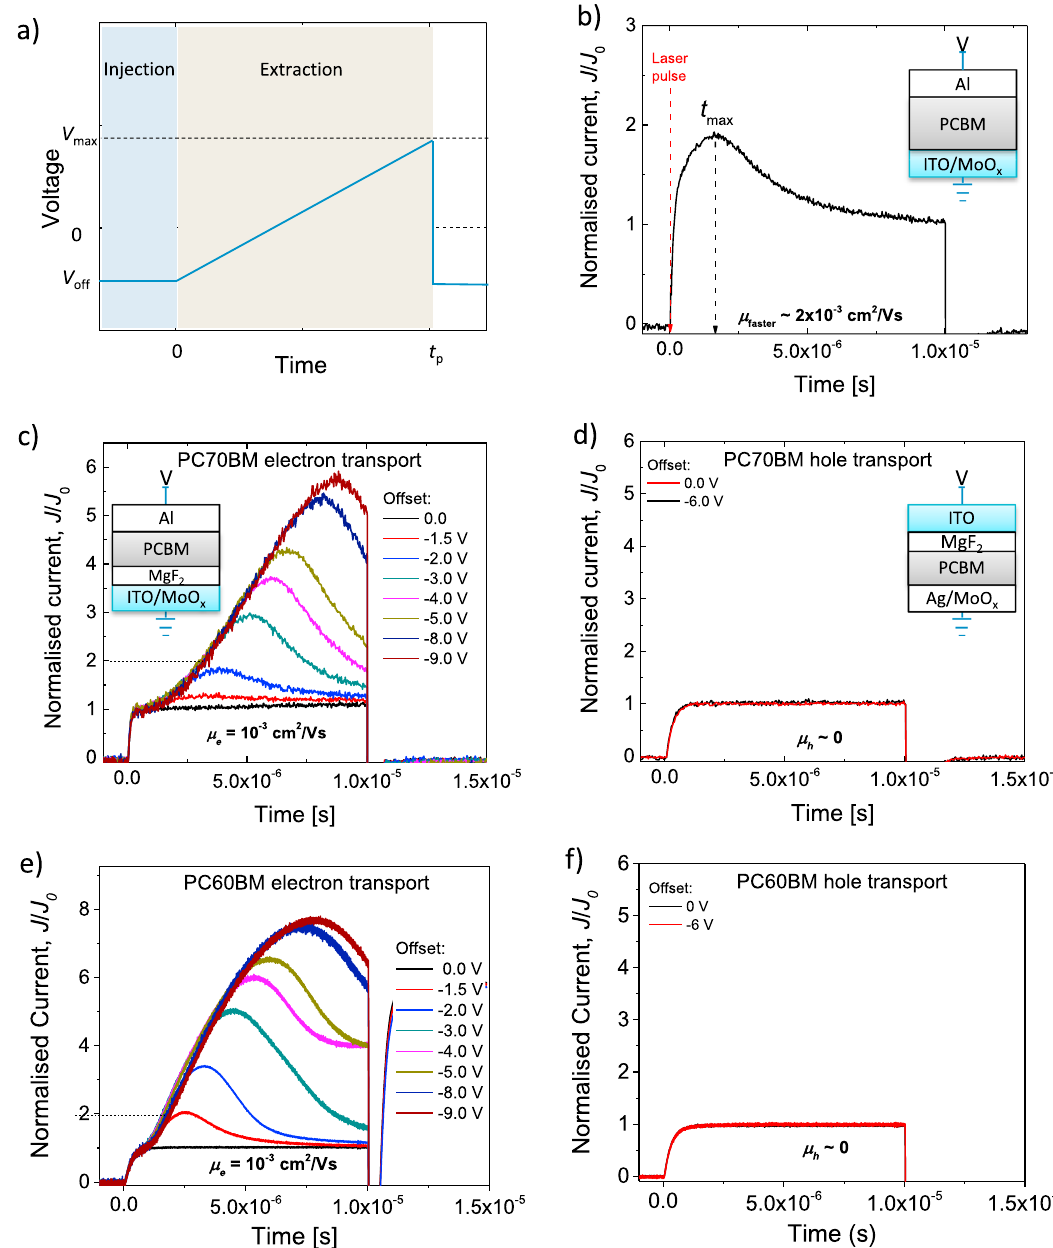
Fig. 1 Photo-CELIV and MIS-CELIV experimental results for PC70BM and PC60BM. a A schematic of the pulse shape used in photo- and MIS- CELIV measurements. At t < 0 a negative offset is applied to the device (forward bias) allowing injection of carriers (only for MIS-CELIV) and t > 0 the triangle voltage pulse extracts the injected carriers. b Photo-CELIV transient for a PC70BM diode structure is shown in the inset. The faster carrier mobility is measured, as photo-CELIV is insensitive to the slower carrier mobility. c MIS-CELIV transient for an electron-only diode shown with its biasing conditions in the inset. The measured electron mobility is in agreement with photo-CELIV. d MIS-CELIV transients for a hole-only diode showing no hole mobility can be detected for PC70BM. MIS-CELIV transients of PC60BM are shown in e and f for electron and hole only devices,